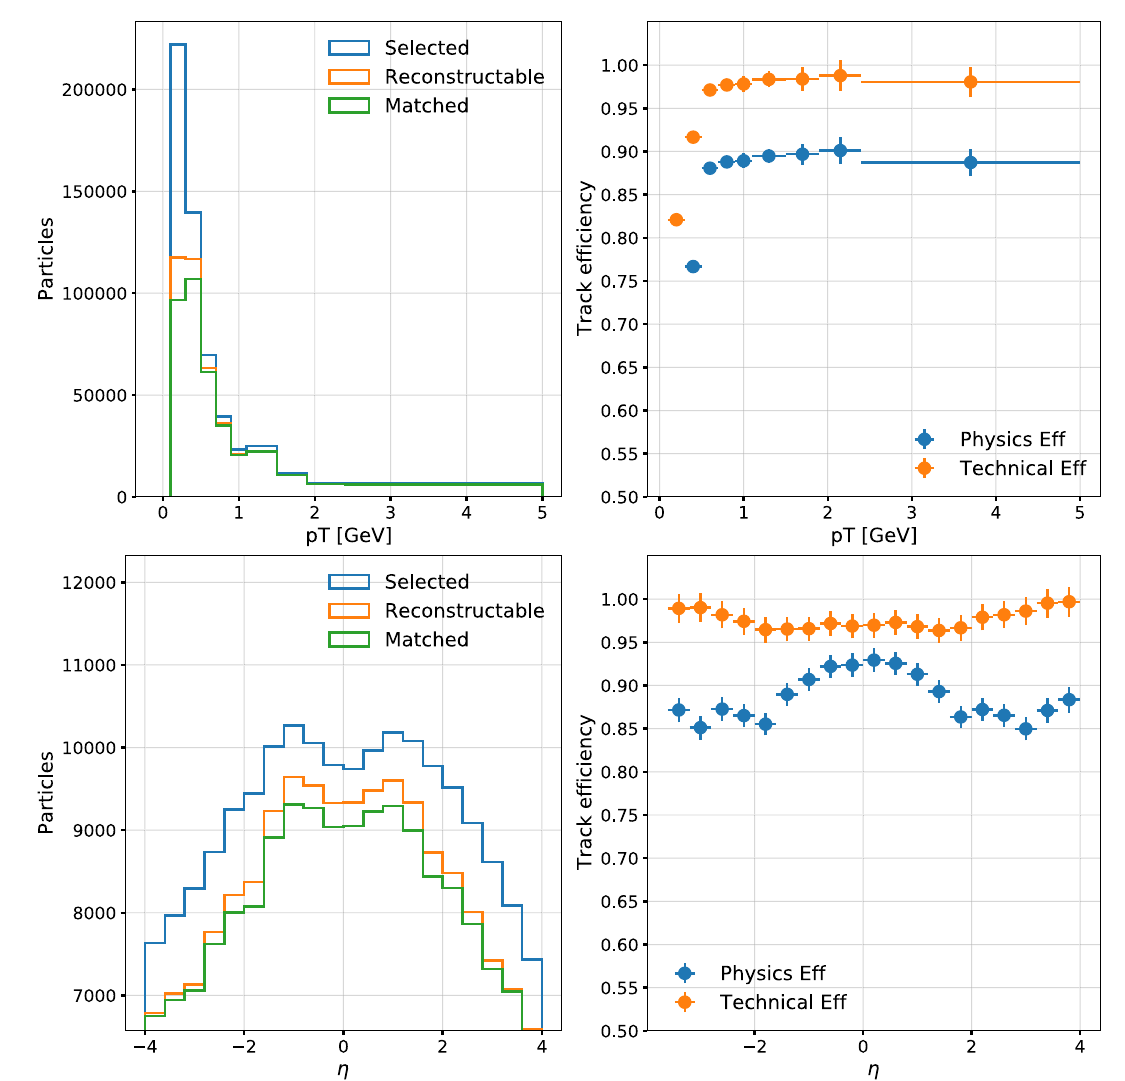
Fig. 5 Top row: selected, reconstructable, and matched particles (left) and tracking efficiency (right) as a function of p T for particles with | η | < 4. Bottom row: selected, reconstructable, and matched particles